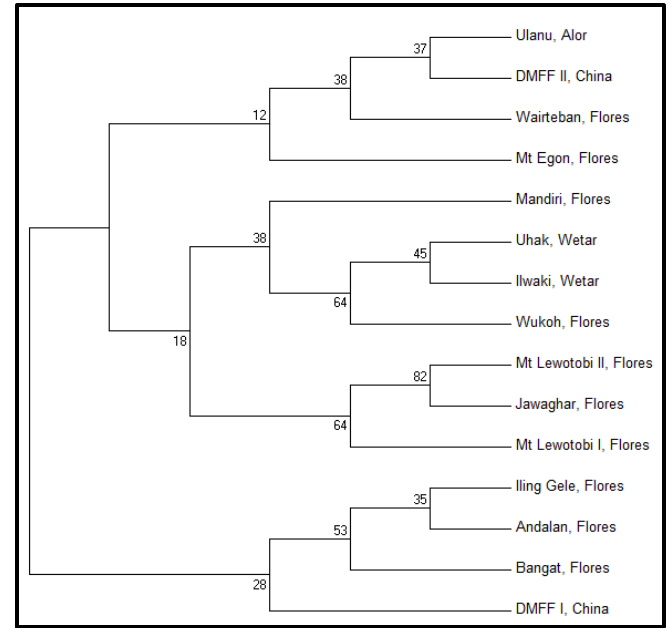
Figure 3. Unrooted neighbor joining (NJ) dendrogram for the 15 E. urophylla provenances (from which 5 or more families were sampled) represented in the first cycle breeding population in China, numbers placed at the head of branches are bootstrap values (based on 1000 iterations).